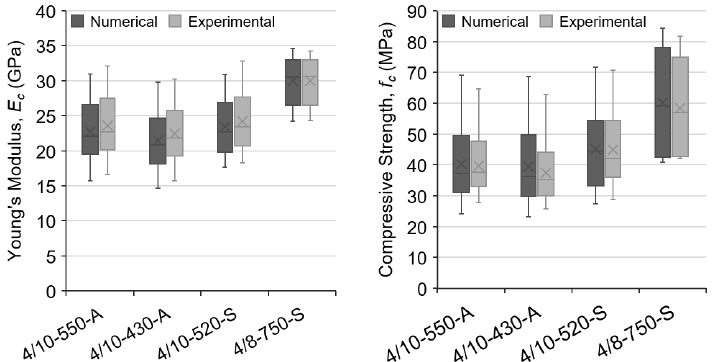
Figure 5 N umerical (dark grey) and experimental (light grey) results of the mechanical properties of LWAC for each type of LWA: left - Young’s modulus; right - compressive